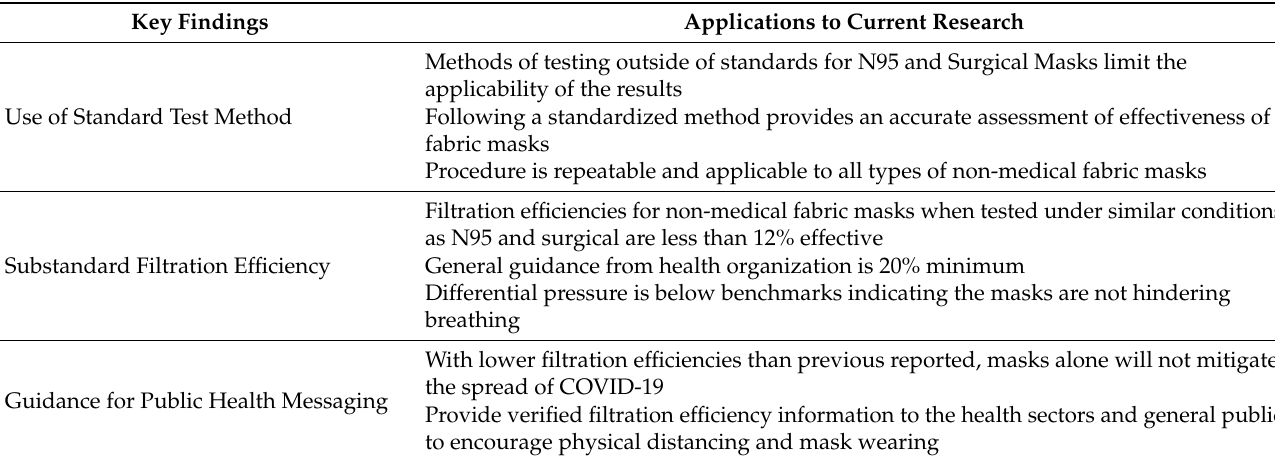
Table 4. Summary of Key Findings and Application to